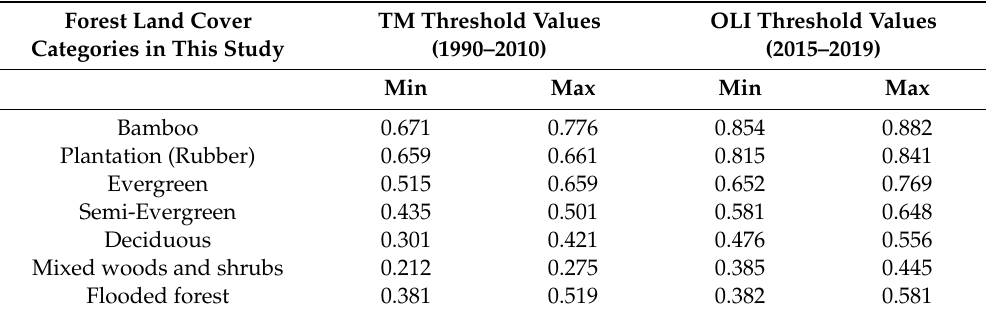
Table 2. EVI threshold values used for forest land cover change detection in the Siem Reap province, Cambodia, using Landsat